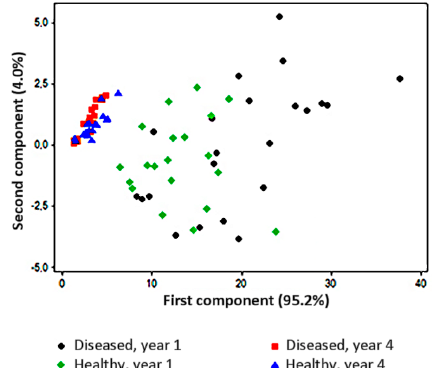
Figure 3. Score plot on the plane defined by the first two principal components of e-nose readings taken on healthy or A. vitis -infected grapevine rootstocks, 1 or 4 years after inoculation. The analysis was performed using the PEN3 e-nose with direct headspace sampling on 20–25 cm rootstock segments placed at 40 °C overnight in individual 150 mL glass tubes containing silica gel (approx. 3 g) as a